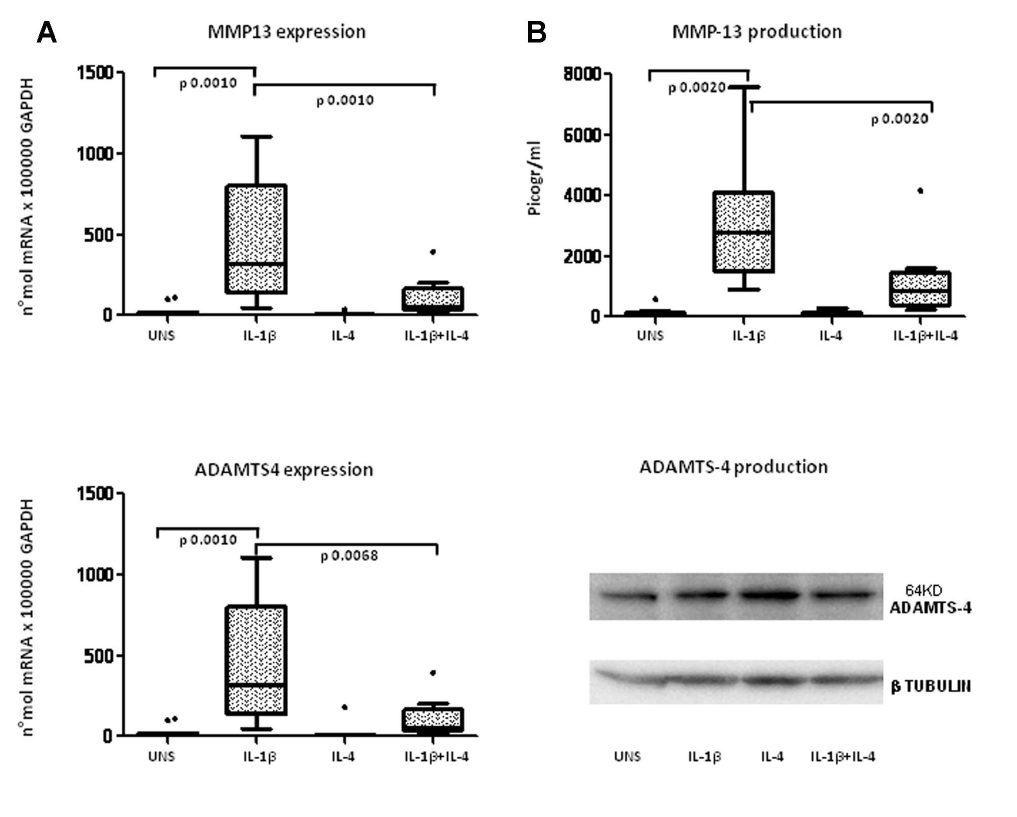
Figure 7. Evaluation of IL-4 anti-inflammatory activity on extracellular matrix-degrading enzymes (MMP-13 and ADAMTS4) in high- density OA chondrocytes. A: mRNA expression; B: protein production. MMP-13 was detected in chondrocytes (cells and culture supernatants) after 24 hours of incubation in unstimulated conditions (UNS) and in the presence of IL-1 b (2 ng/ml), IL-4 (10 ng/ml), or a combination of the two cytokines. Whereas ADAMTS4 mRNA was detected as for the other transcripts, ADAMTS4 protein was assessed in lysates of cells scraped with their extracellular matrix. WB show the band at 64 kDA along with b -tubulin as a loading control. Boxes indicate the 25% and 75% percentiles, whiskers indicate the minimum to maximum values, bars indicate the median; and solid circles indicate outliers. After Bonferroni’s correction, p values below 0.0165 were considered significant.